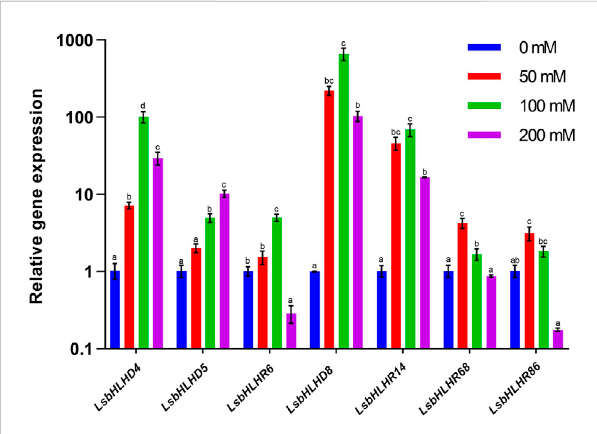
FIGURE 7 Gene expression pro fi les of seven selected LsbHLH were determined using different salt concentrations following a 72-h course. qPCR-analysis was used to determine the relative expression levels of the LsbHLH in seedlings treated with 50, 100, and 200 mM NaCl. Signi fi cant differences between treatments are indicated by a small letter (s) above the bars ( p ≤ 0.05; LSD). The 2 − △△ Ct method was used to calculate the relative expression